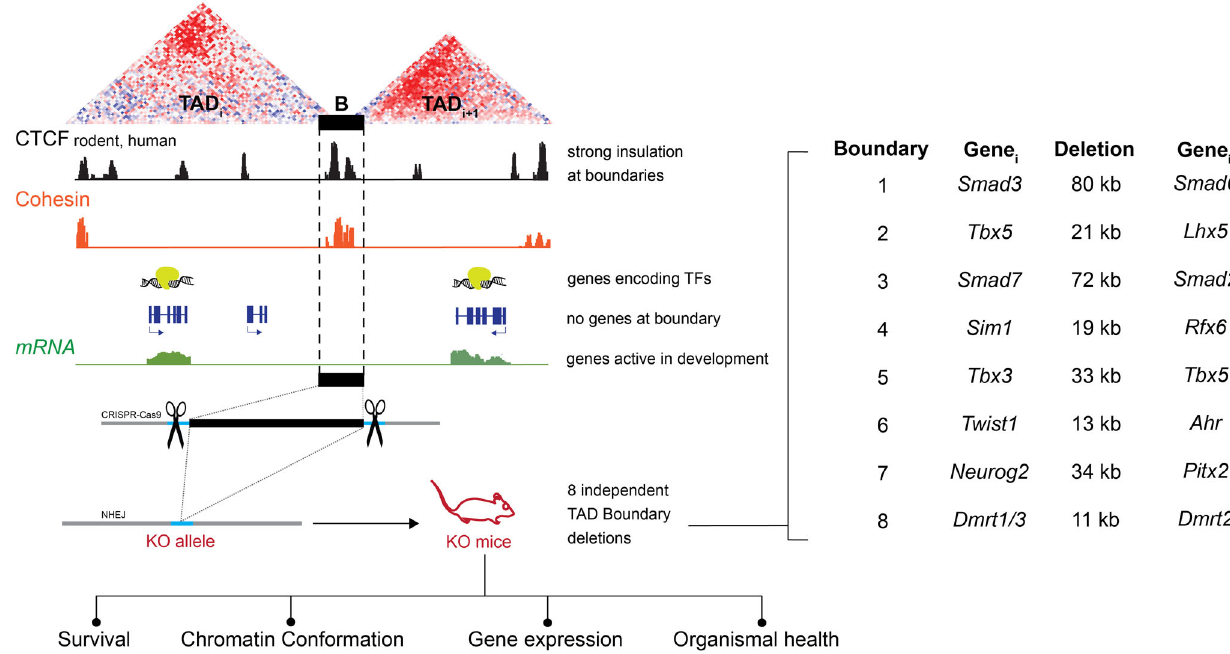
Fig. 1 Study overview. Schematic showing the selection and CRISPR/Cas9-based deletion strategy for removal of TAD boundaries in vivo, along with types of phenotyping performed on the resulting knockout (KO) mice. Speci fi c boundaries individually deleted, along with selected developmentally expressed genes fl anking each deleted boundary are also depicted. B boundary element, TFs transcription factors.